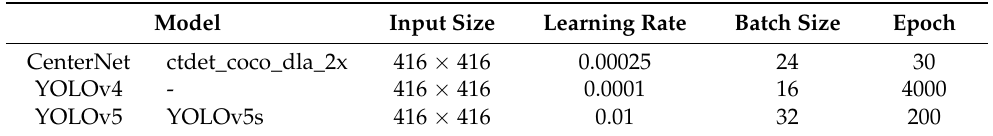
Table 2. Configuration for training for selected deep learning algorithms. Model Input Size Learning Rate Batch Size Epoch CenterNet ctdet_coco_dla_2x